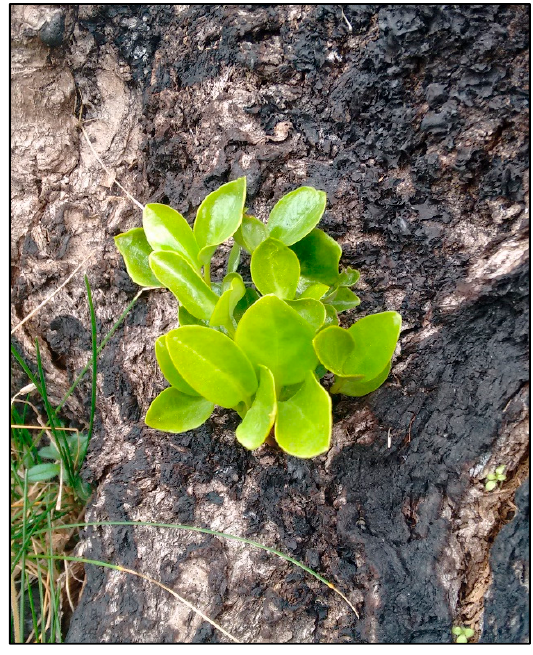
Figure B2. Fuchsia excorticata resprouting. Figure B3. Coprosma robusta/lucida resprouting. Figure B4. Griselinia littoralis resprouting. Figure B5. Melicytus ramiflorus resprouting Figure A4. Griselinia littoralis resprouting.